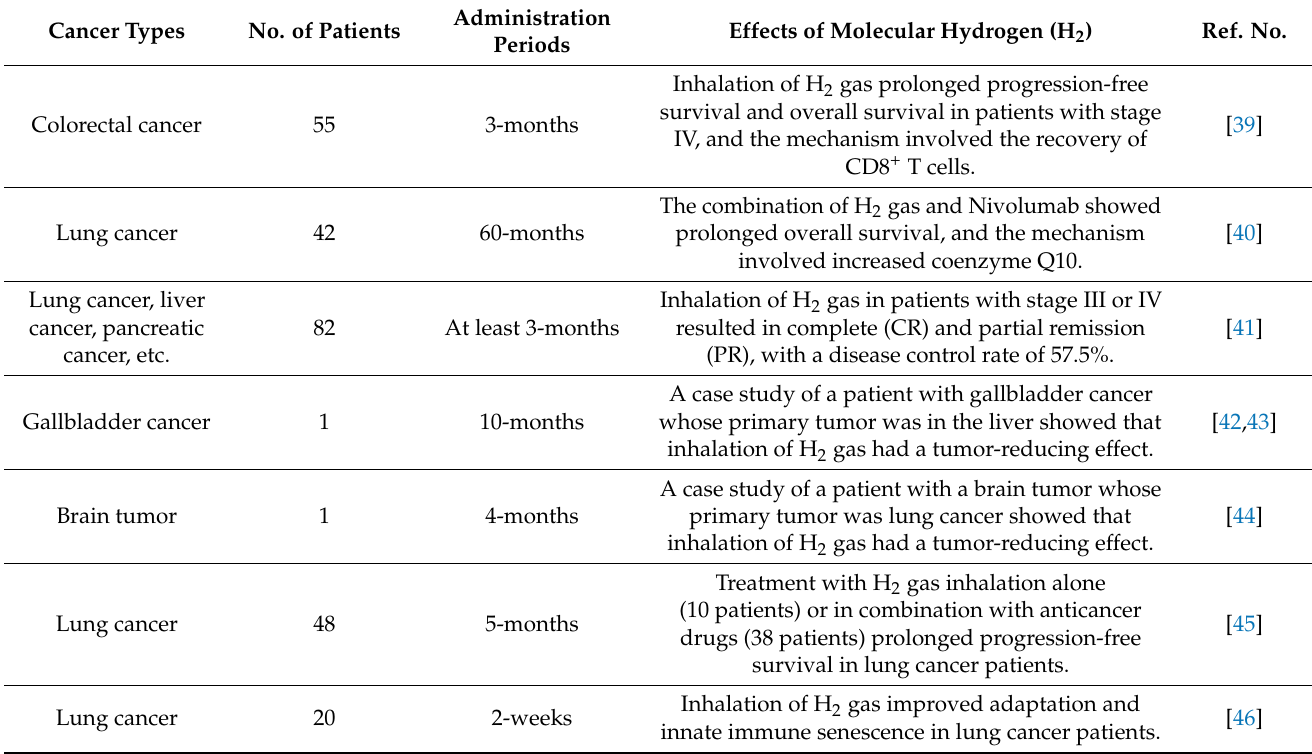
Table 2. Summary of antitumor effects of molecular hydrogen (H 2 ) in human clinical